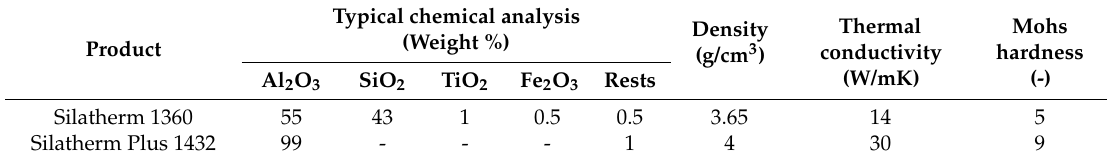
Table 1. Composition and some physical properties of AlS and AlO (information from manufacturer).